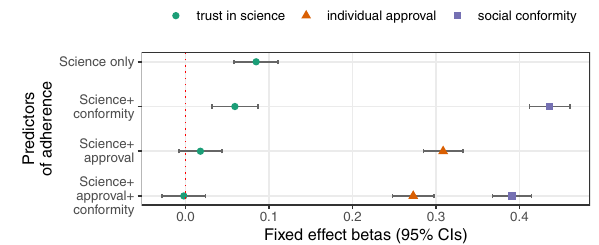
Fig. 1 Standardised effects (linear regression betas) with 95% credible intervals (CIs). These show the effects of trust in science, individual approval, and social conformity on adherence behaviour, according to which predictors were included in each